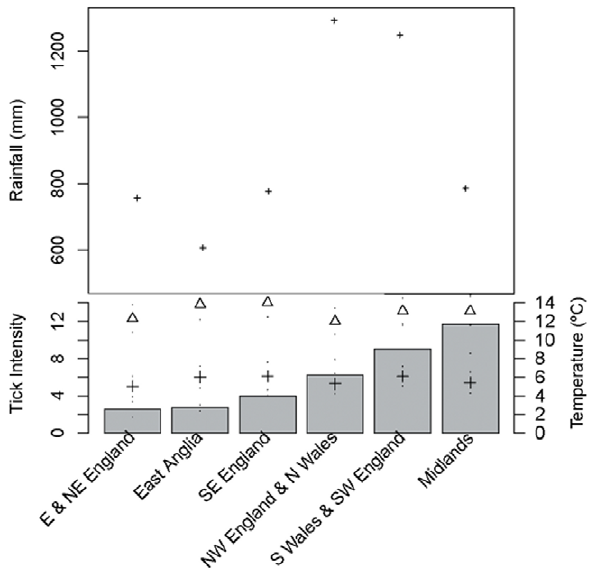
Figure 4. Abiotic impact on tick intensity. Mean tick intensity (grey bars) in each meteorologically distinct region (East and Northeast England, East Anglia, Southeast England and Central South, Northwest England and North Wales, South Wales and Southwest England, and Midlands) and corresponding 30 year average (1971–2000) summed mean rainfall (mm) (upper Y-axis), maximum (triangle) and minimum (cross) 30 year (1971–2000) average temperature ( u C) for each region (lower Y-axis). Standard error marks for rainfall, maximum and minimum temperature correspond to variability in monthly averages.